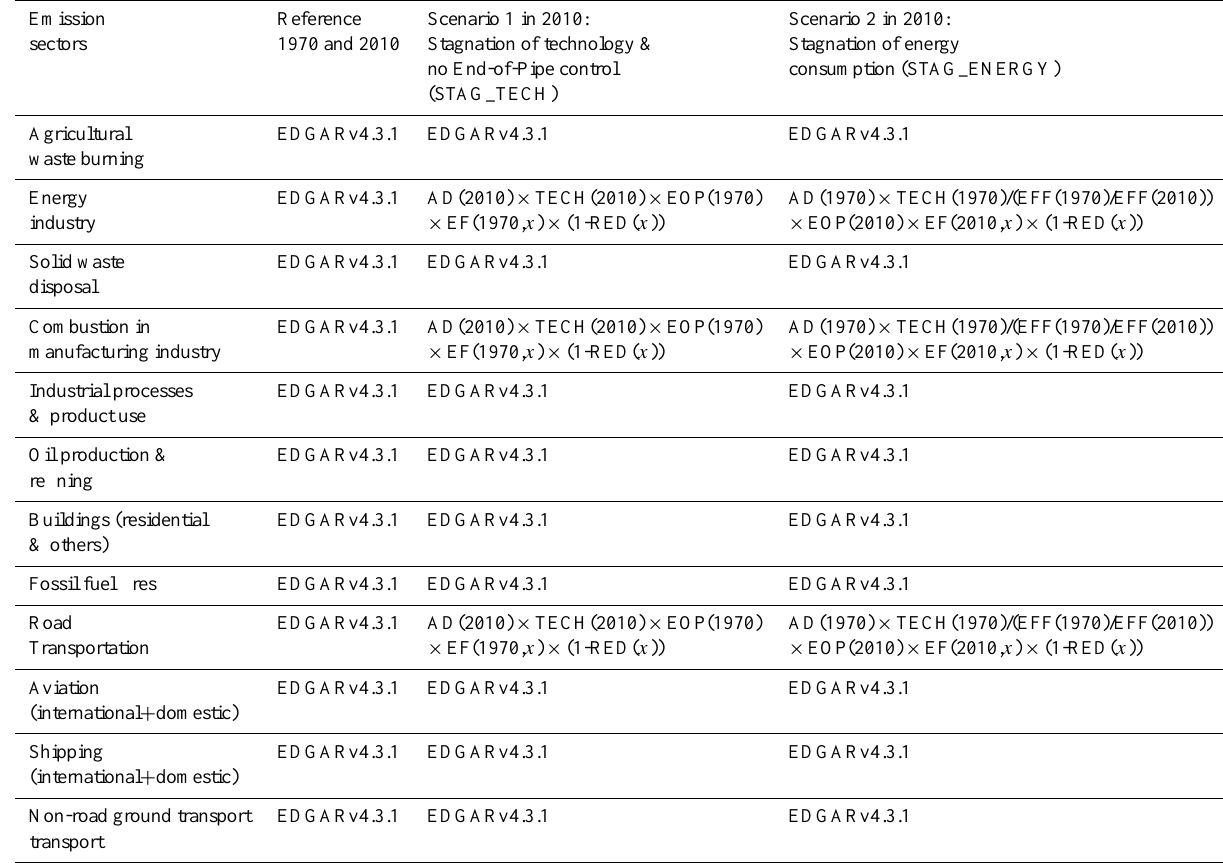
Table 1. Emission scenario assumptions. AD (activity data), EF (emission factors), RED (reduction factor), EFF (efficiency factor), TECH (technology), EOP (end-of-pipe) and substance x